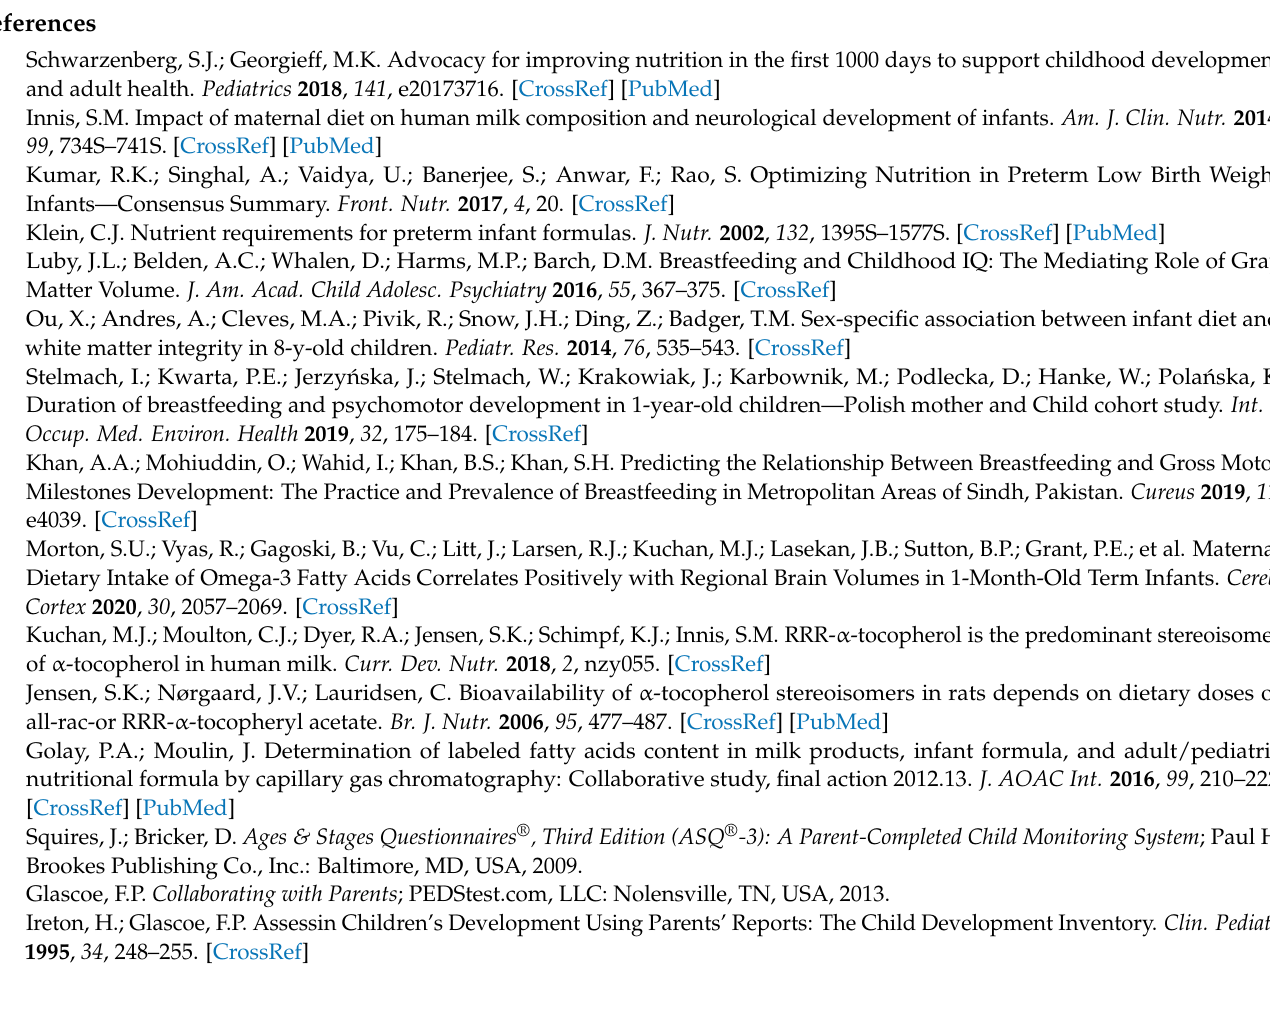
Figure A1. Participant flow chart from parent study cohort to subset of participants with relevant data for the current analysis.